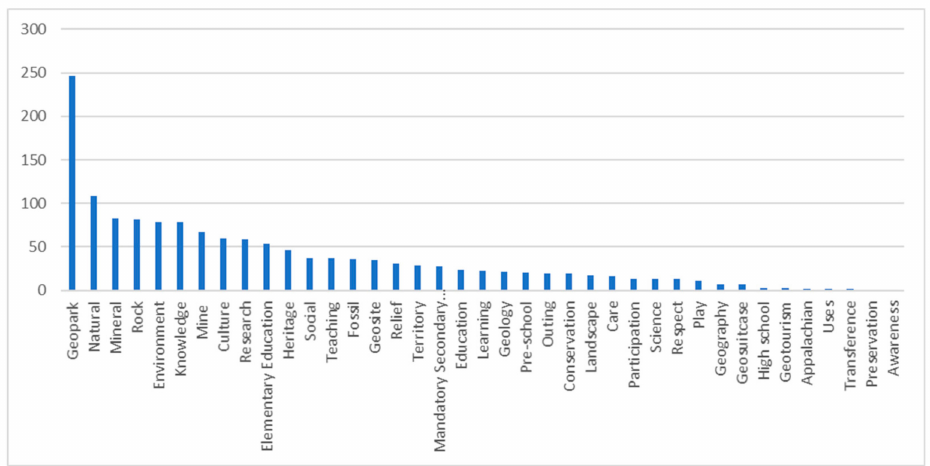
Figure 8. Absolute values for each subcategory found in the activities. Source: compiled using data provided by the UNESCO Global Geopark Villuercas-Ibores-Jara